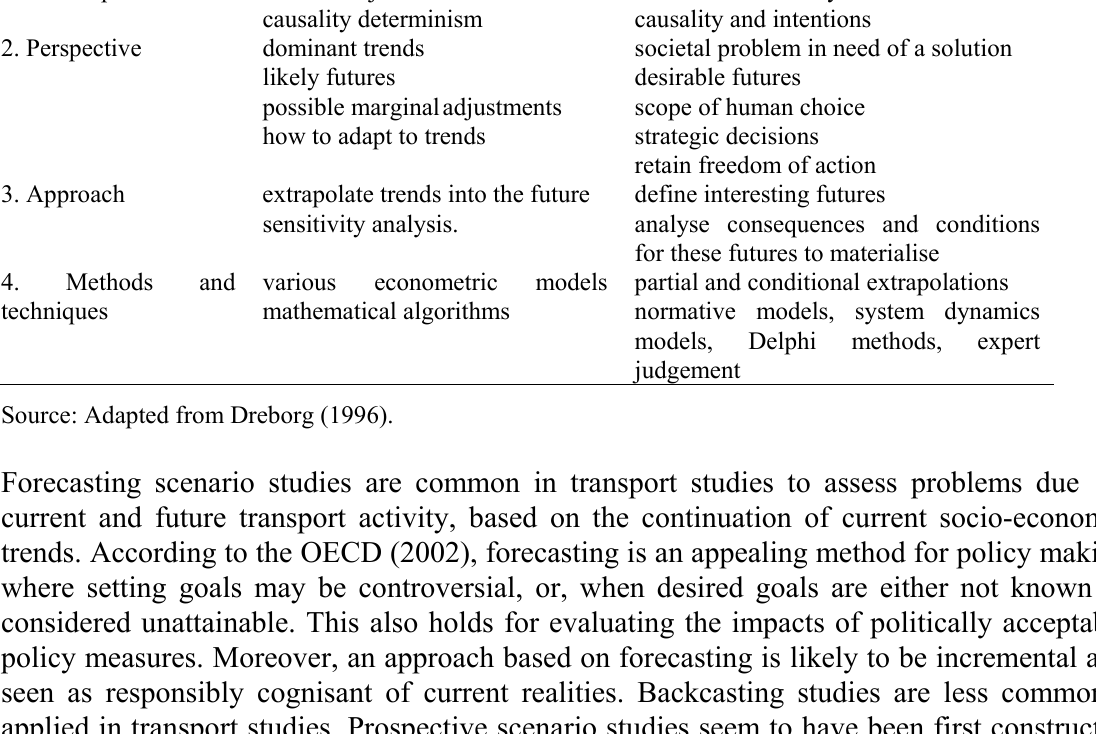
Table 1: Differences between forecasting and backcasting studies Level Forecasting Backcasting 1. Philosophical view context of justification context of discovery causality determinism causality and intentions